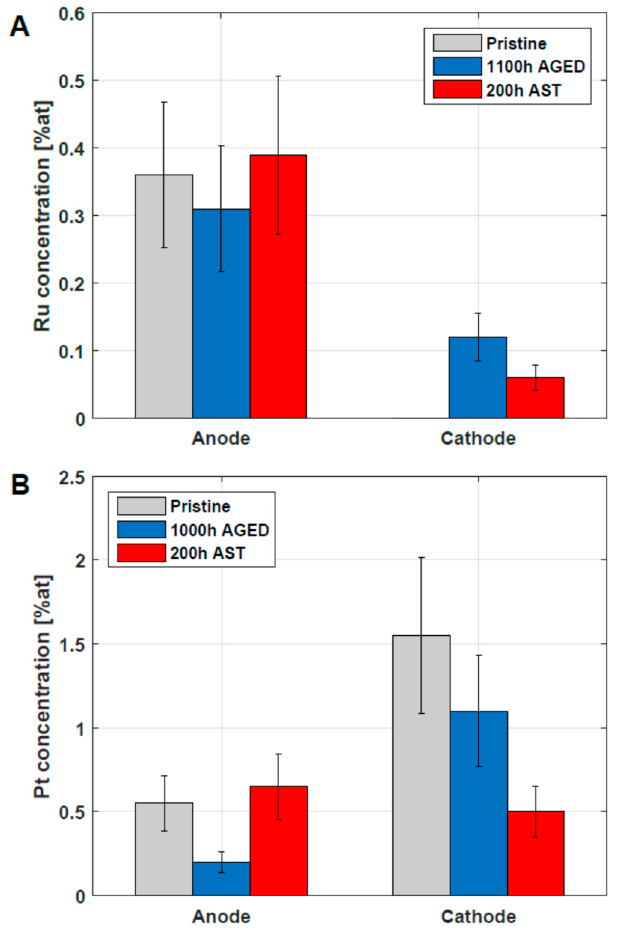
Figure 7. Veri fi cation of Ru ( A ) and Pt ( B ) in anode and cathode CL of pristine, 1100 h aged and 200 h AST MEAs. The analysis was carried out using XPS and the concentration is related to total con- centration of analyzed elements (Pt, Ru, C, F, O). The uncertainty of the data is around 30%